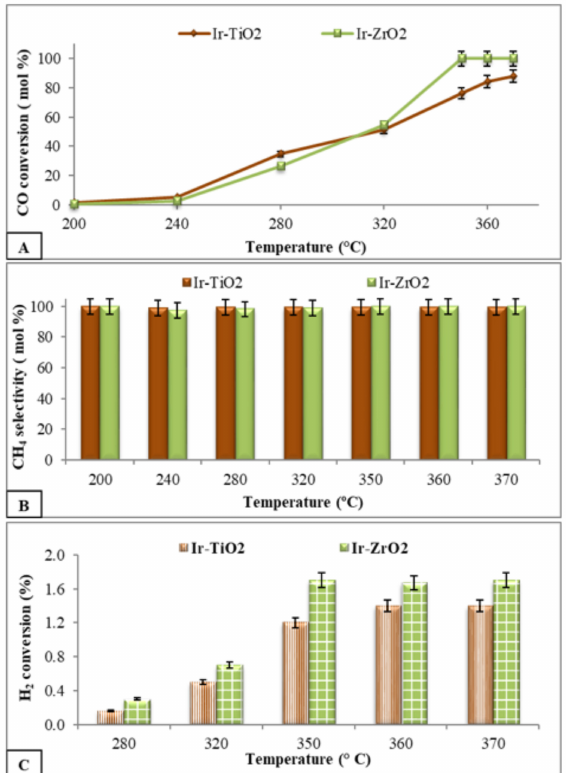
Figure 10. CO hydrogenation reaction over the TiO 2 and ZrO 2 supported catalysts with increasing temperatures, CO conversion ( A ), CH 4 selectivity ( B ) and H 2 conversion ( C ) (GHSV 12,000 h − 1